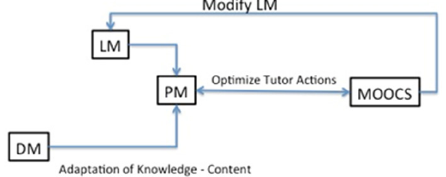
Figure 2. Presentation and relations of LM, PM. adn DM